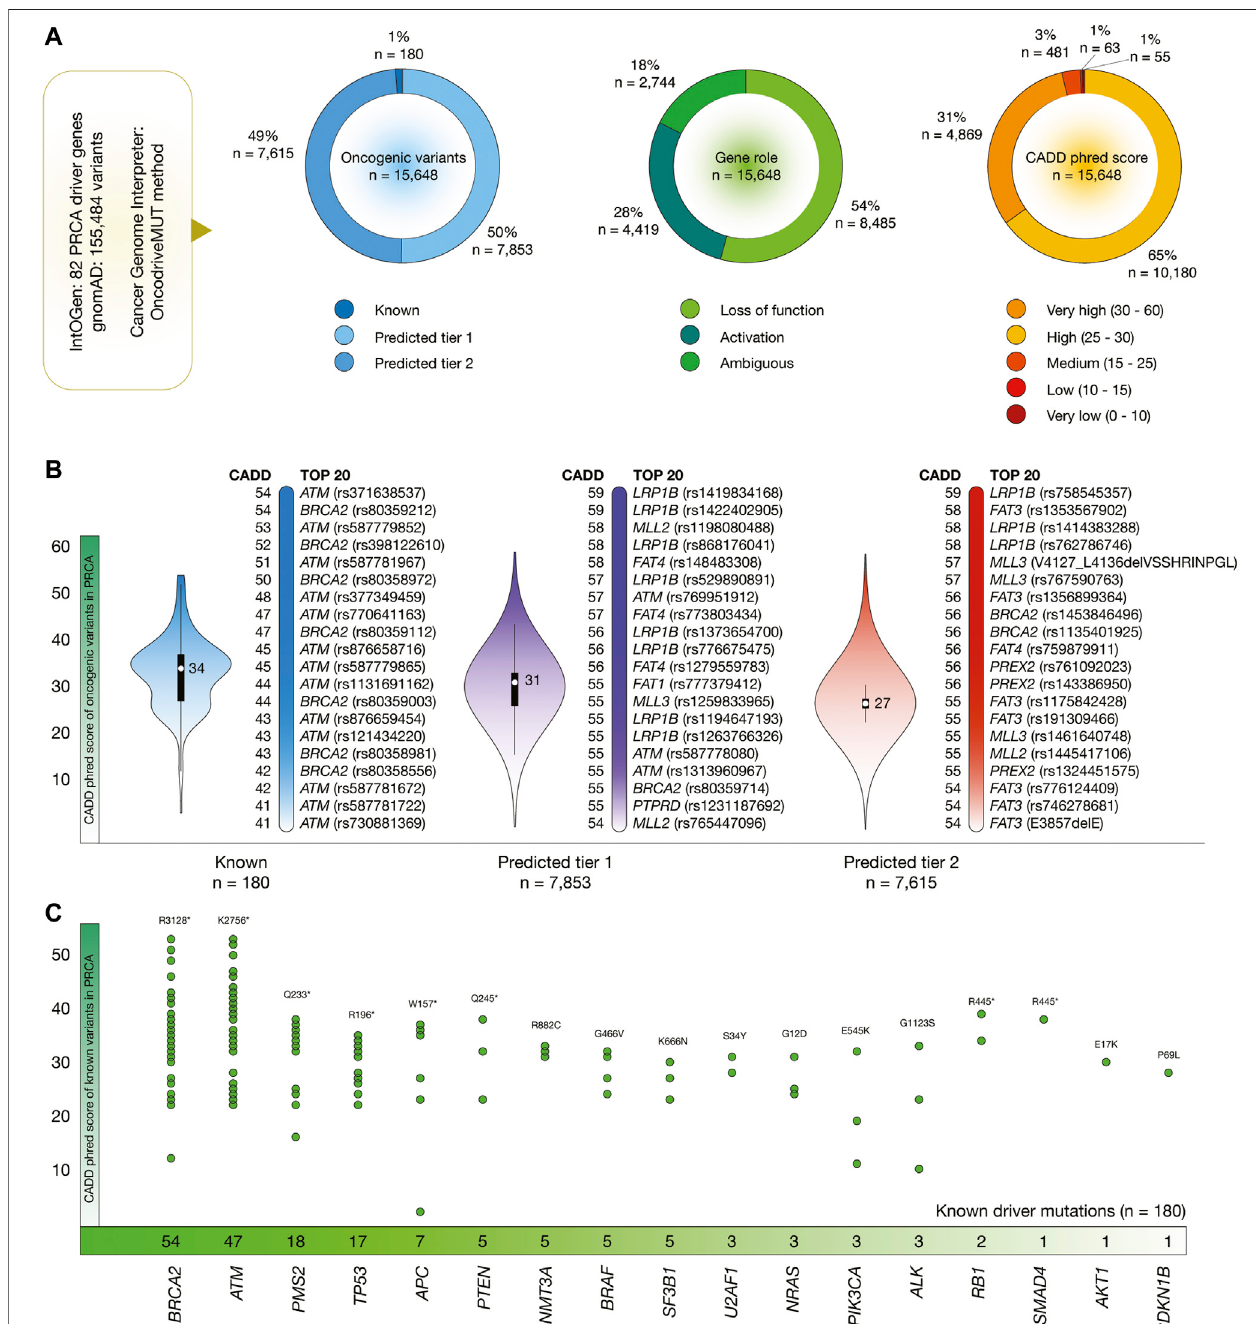
FIGURE 4 | PRCA driver genes, oncogenic variants, and deleteriousness scores. (A) Features of PRCA driver genes and oncogenic variants. (B) Bean plots of CADDphredscoresofPRCAoncogenicvariants,andrankingofknownoncogenicvariantswiththehighestCADDphredscores. (C) PRCAdrivergeneswiththehighest number of oncogenic